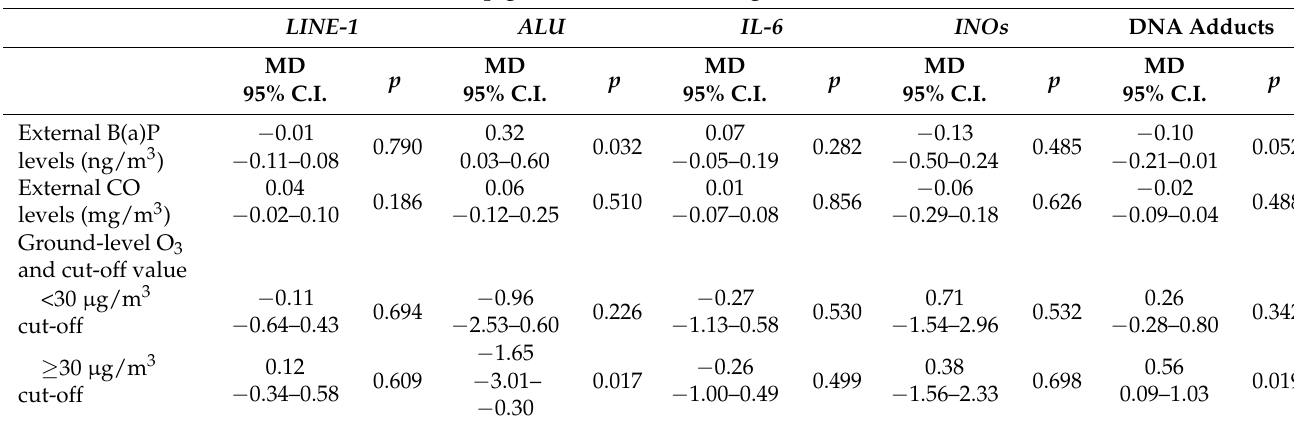
Table 4. Means Difference (MD) and 95% Confidence Intervals (C.I.) of DNA methylation in the repetitive elements of the Long Interspersed Nuclear Element-1 ( LINE-1 ) and ALU , and in promoter domains of the interleukin-6 ( IL-6) and inducible nitric oxide synthase (i NOS) genes, and MD and 95% C.I. of bulky DNA adducts according to the concentrations of benzo(a)pyrene [B(a)P ng/m 3 ], carbon monoxide (CO mg/m 3 ) and ground-level ozone (O 3 µ g/m 3 ). MD and 95% C.I. of biomarkers were also examined using a cut-off value of 30 µ g/m 3 O 3